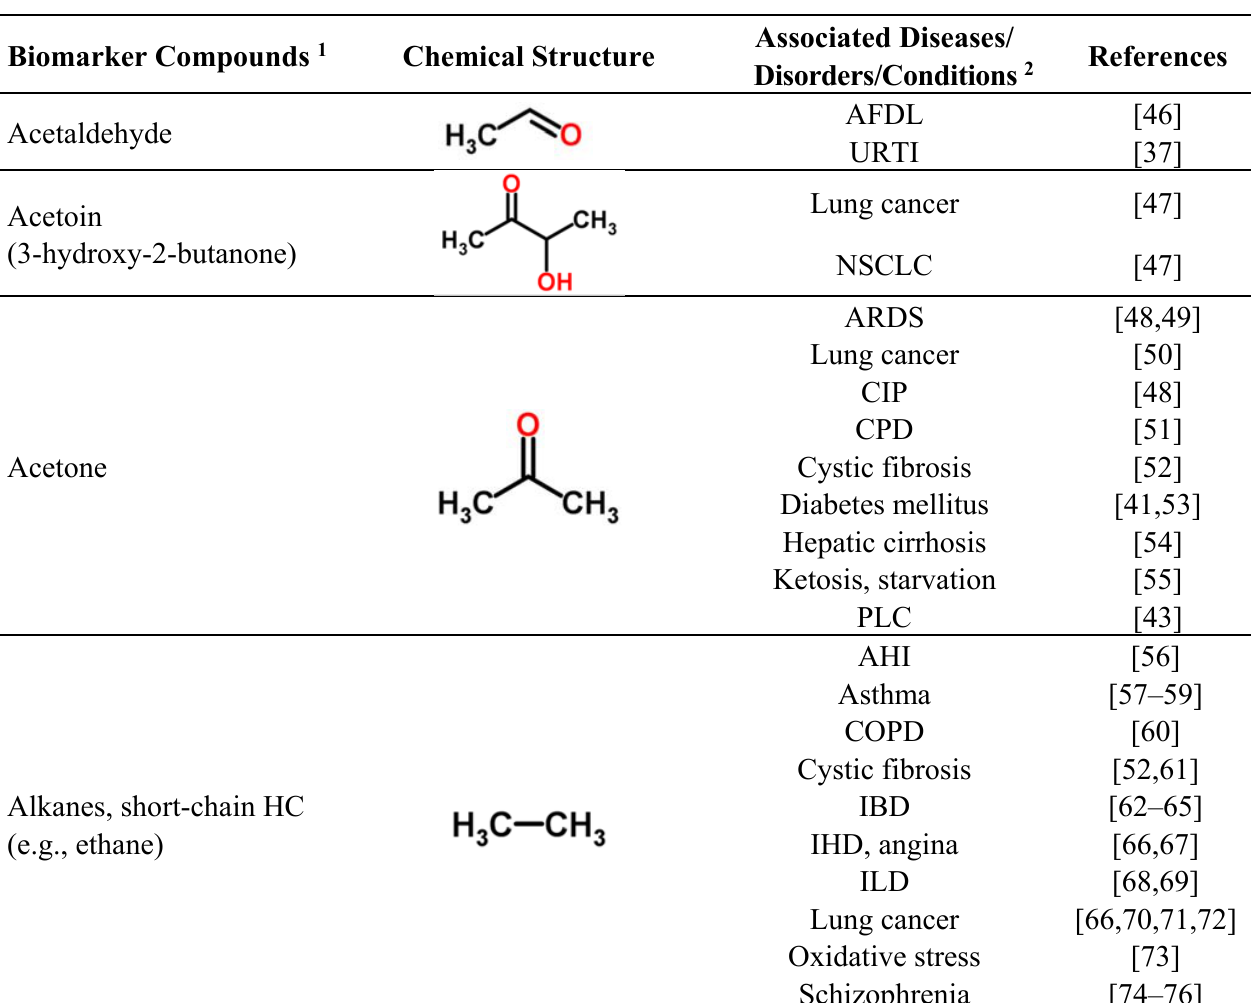
Table 2. Volatile biomarker compounds in the human breath that are associated with the presence of multiple specific diseases, genetic disorders or adverse physiological conditions in the